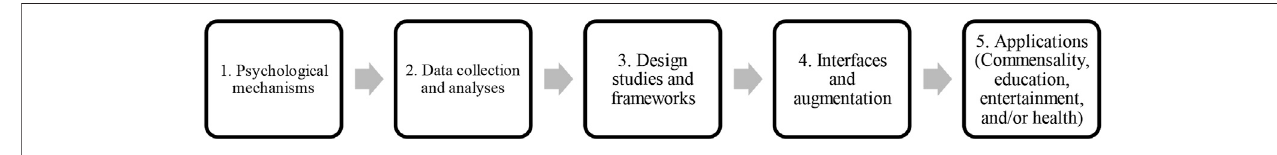
FIGURE 1 | Possible themes associated with research and development in